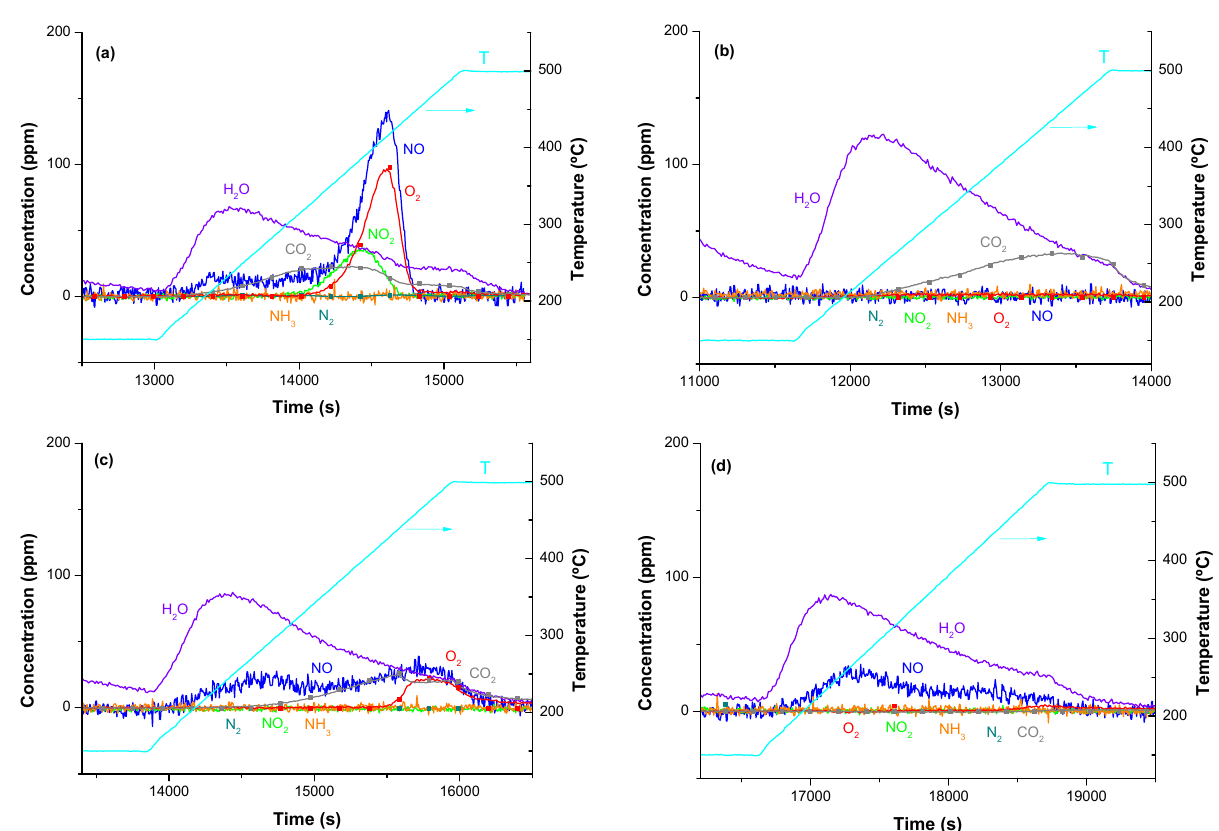
Figure 7. N 2 , NH 3 , NO, NO 2 , O 2 , and H 2 O outlet concentrations during final TPD step, under He (after NO x storage and H 2 reduction at 150 °C), for the catalysts: ( a ) CZ; ( b ) Cu2/CZ; ( c ) Ba6/Cu2CZ; and ( d ) Ba11/Cu2CZ. (Ba6/CZ not included due to very low catalytic response). Table 3. NO x /O 2 ratios estimated from the TPD step under He, for CZ and Ba6/CZ, after NO x storage and reduction at the temperatures selected, and the corresponding temperature (T max ) of the maxi- mum NO + O 2 release, in parenthesis.